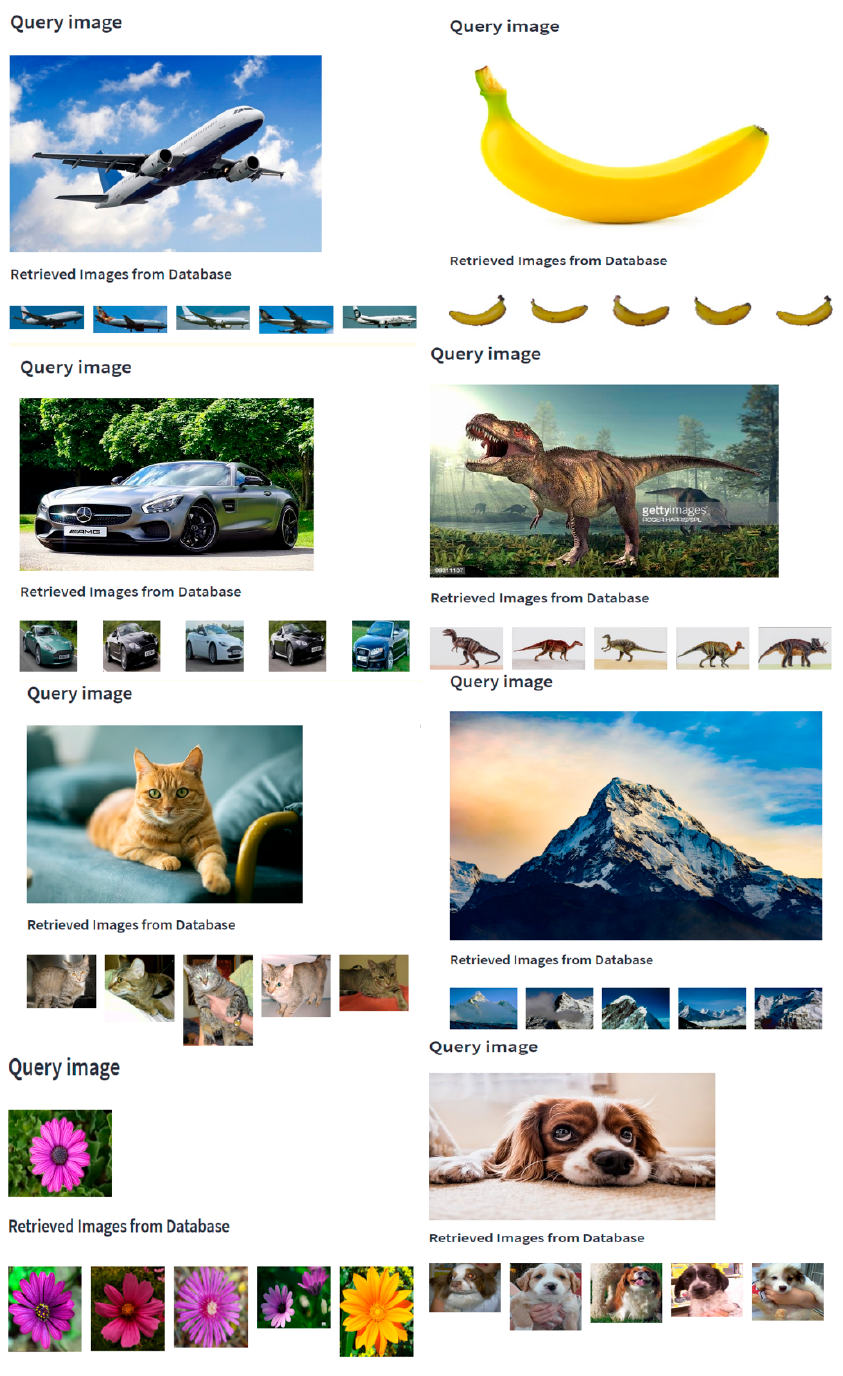
Figure 7. Performance of CBIR on random images.